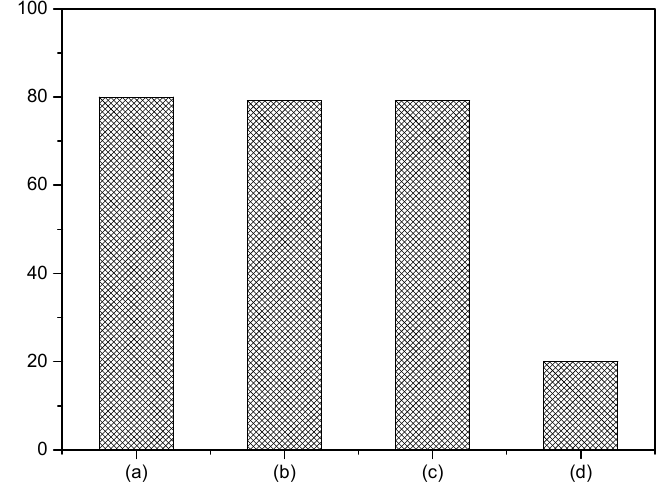
Figure 10. Evaluation results of charging waiting time.